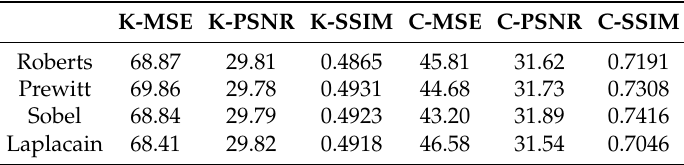
Table 5. Baseline model with four